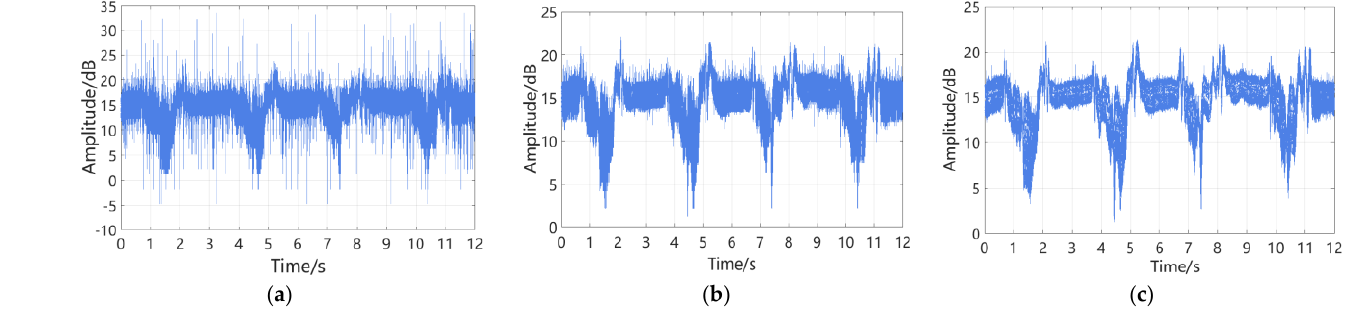
Figure 5. Data processing: ( a ) Raw data. ( b ) Data after Kalman filter processing. ( c ) Sym8 Wavelet processed data.